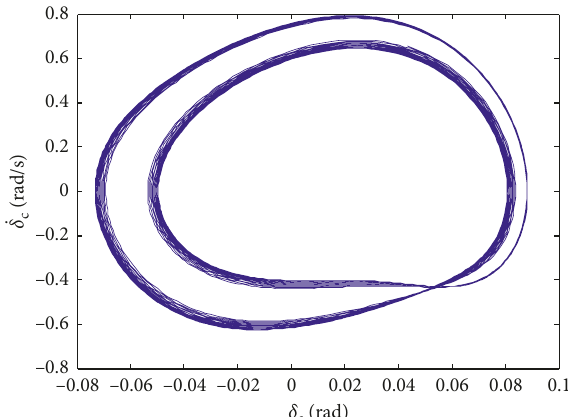
0.3, m c 100kg. (cid:30) (cid:30)